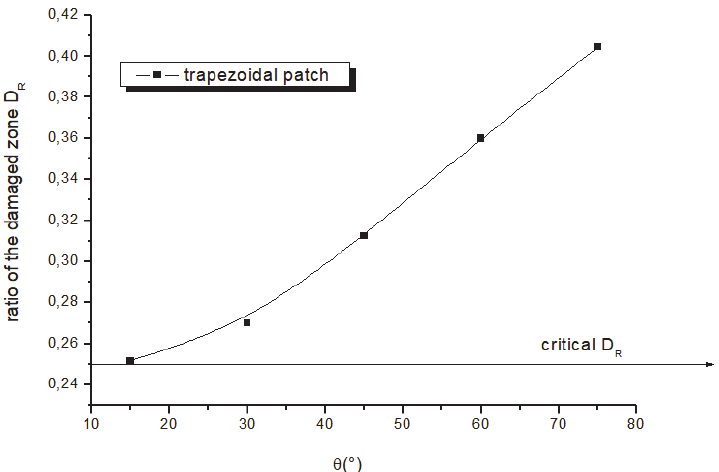
Figure 7: Ratio of the damaged zone according to the crack tilt.